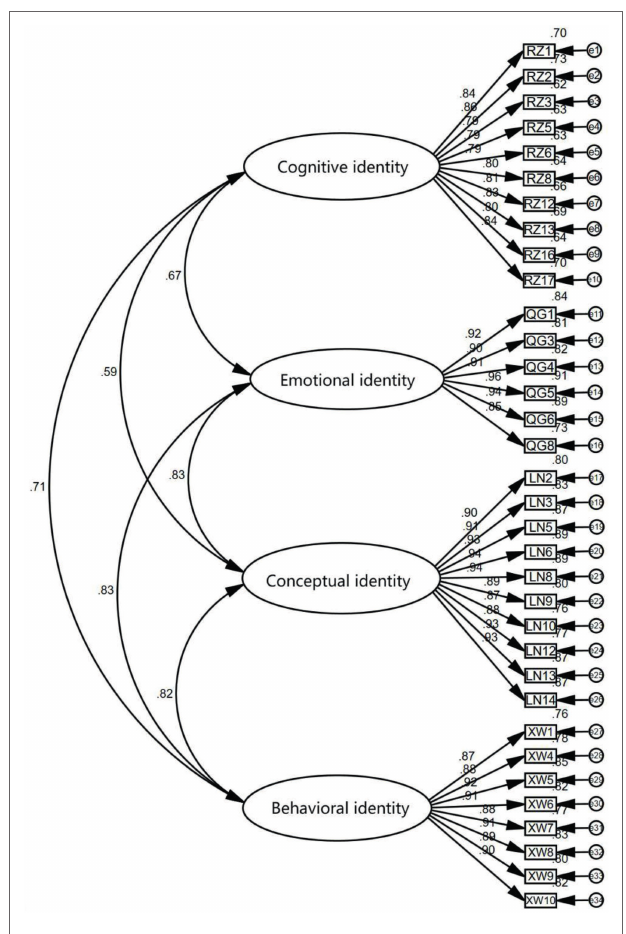
FIGURE 1 | Confirmatory factor model.